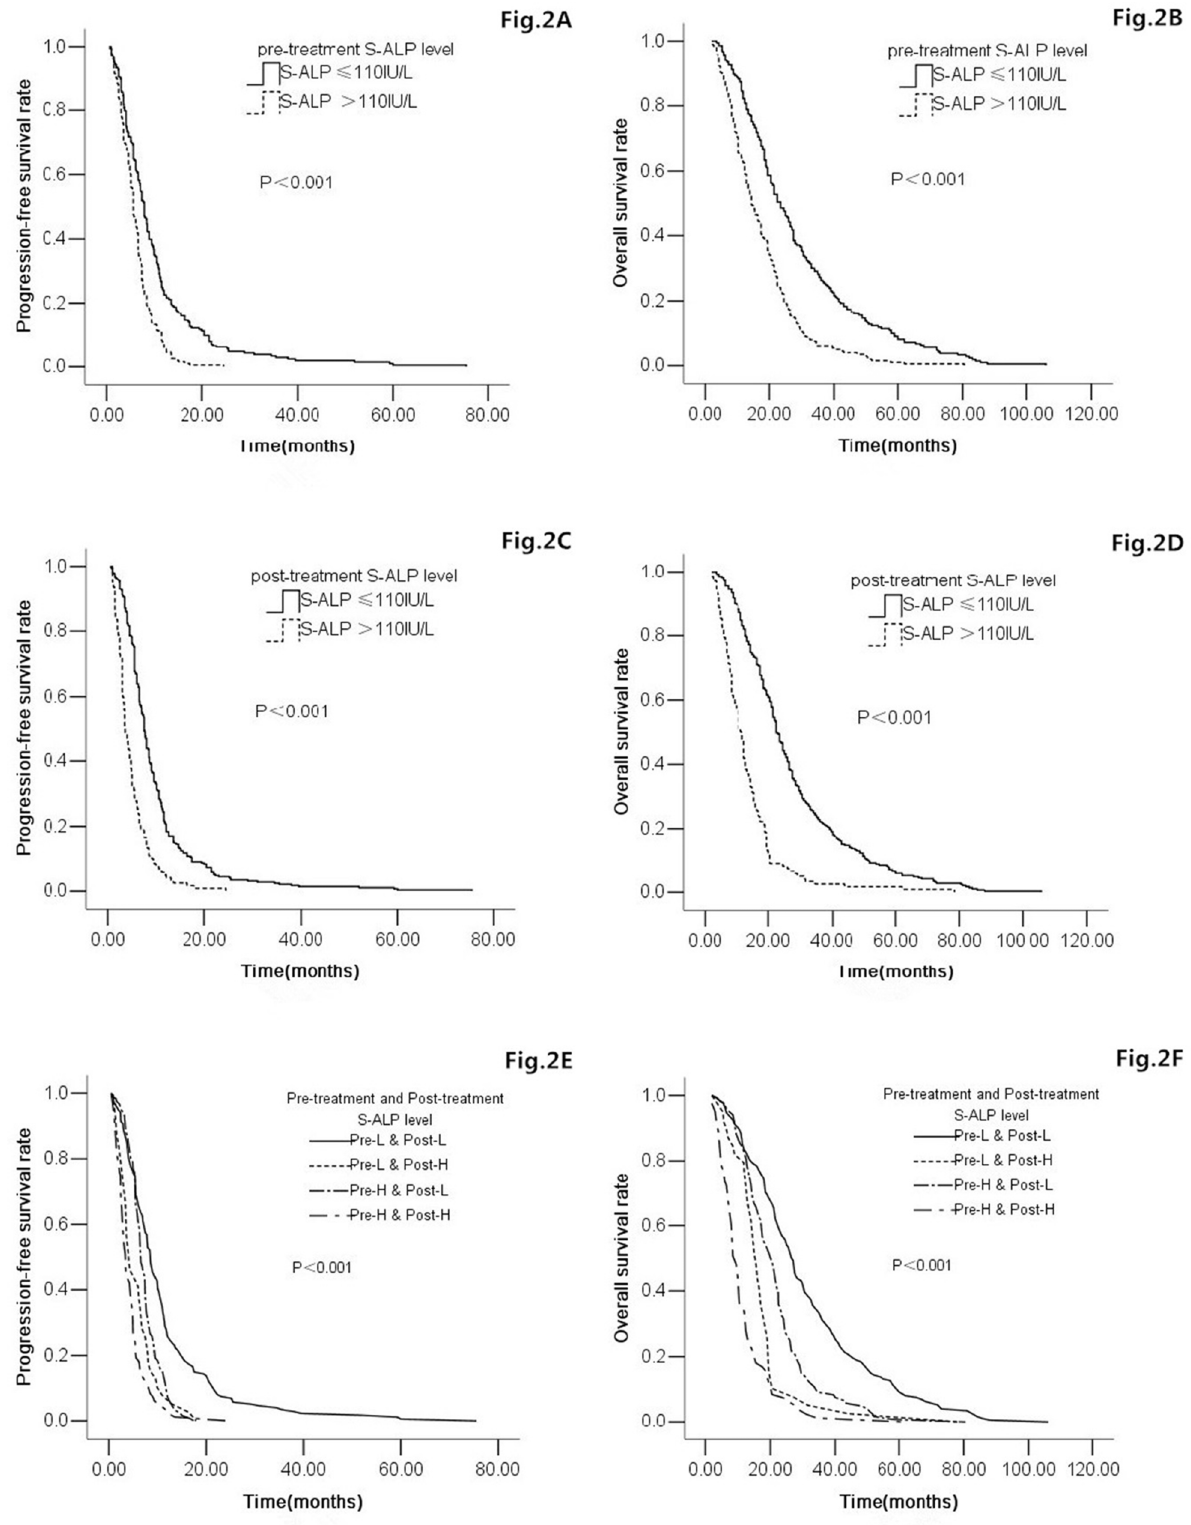
Figure 2 - Kaplan-Meier survival curves are shown for the total sample of 416 patients according to the pre-treatment (and post- treatment) S-ALP level. A) PFS according to the pre-treatment S-ALP ( P o 0.001). B) OS according to the pre-treatment S-ALP ( P o 0.001). C) PFS according to the post-treatment S-ALP ( P o 0.001). D) OS according to the post-treatment S-ALP ( P o 0.001). E) PFS according to the combination of pre-treatment and post-treatment S-ALP ( P o 0.001). F) OS according to the combination of pre-treatment and post-treatment S-ALP ( P o 0.001).